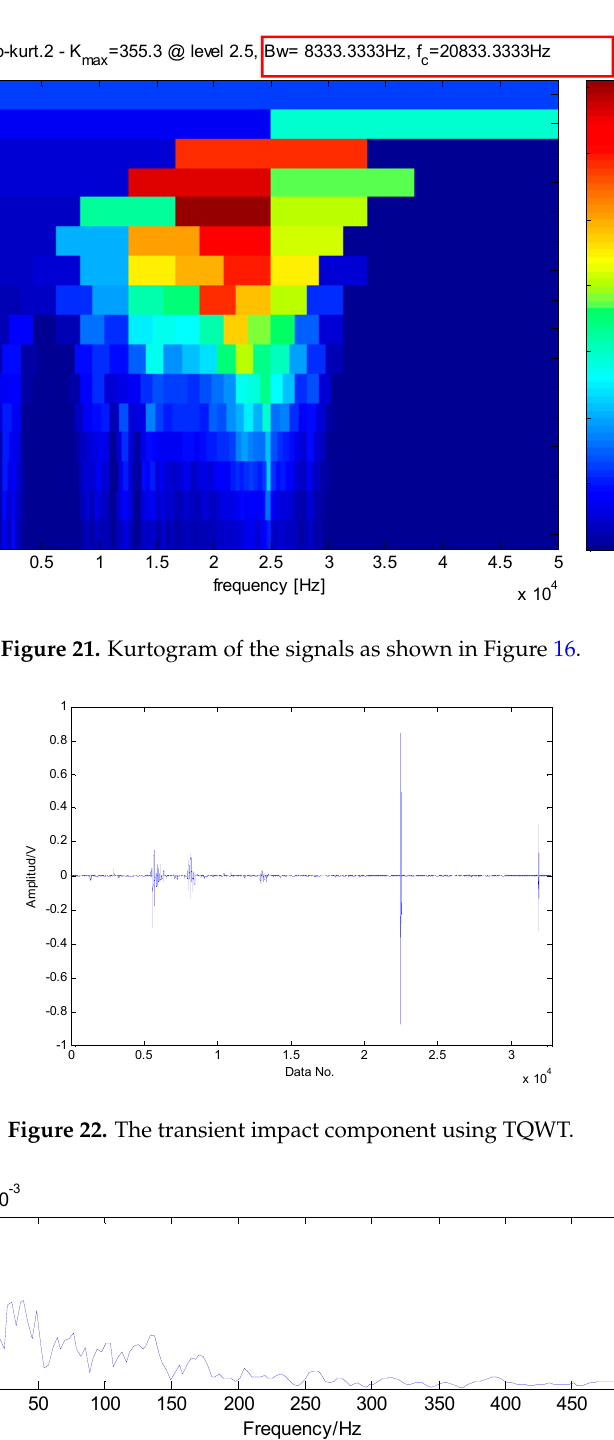
Figure 24. Random sampling of transient impact component through Gaussian random matrix. To successfully extract the fault features, the matching pursuit is utilized and the detected results can be acquired through the matching pursuit, as presented in Figures 25 and 26, containing the fault characteristic frequency and its twice value, which are almost equal to the theoretical values in Table 1. Thus, the judgment that there is a rolling-element fault in this roller bearing can be concluded. Figure 25. The detected fault characteristic frequency through matching pursuit.